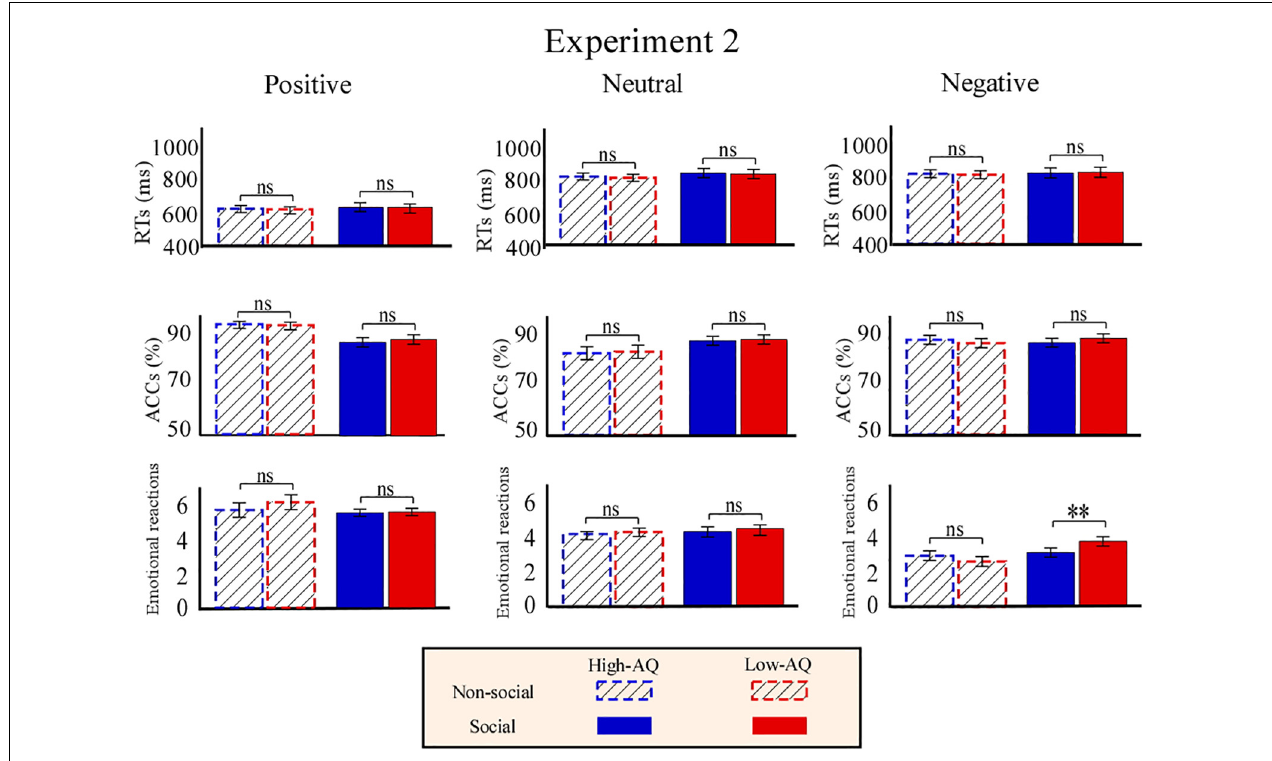
FIGURE 6 | Behavioral results from Experiment 2. Bar charts show responses of High-AQ (blue) and Low-AQ (red) groups to positive (left column) , neutral (middle column) , and negative (right column) pictures with social (solid bar) or non-social (dotted bar) dimensions. Data of RTs, ACCs, and emotional reactions are shown in the top, middle, and bottom panels. Data in the bar charts are expressed as Mean ± SEM. ns p > 0.05, * p < 0.05, ** p < 0.01, *** p <